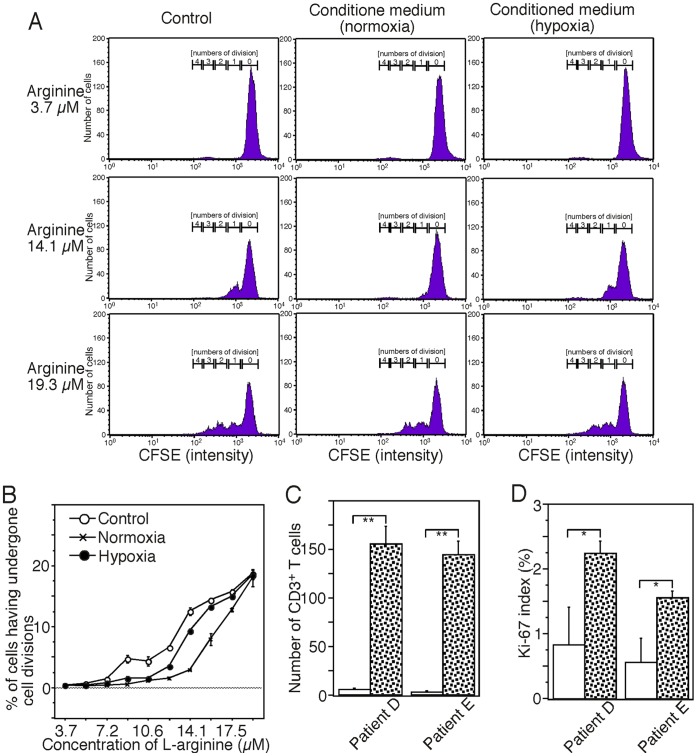
ARG2-expressing CAFs potentially affect the immune reaction.(A) T cell proliferation assay. CFSE-labeled CD3+ T cells were stimulated with anti-CD3/CD28 antibody-conjugated beads in fresh medium supplemented with the indicating L-arginine (control) or in conditioned medium after culture of CAFs under normoxic conditions (normoxia) or hypoxic conditions (hypoxia) in the medium with the indicating L-arginine (including 2.0 µM arginine of serum contents) for four days, and their proliferation profiles were analyzed by flow cytometry. Non-proliferated cells showed the highest fluorescence intensity and the intensity of the labeled T cells was halved with every cell division. The numbers represent the ratio of numbers of cells having undergone multiple divisions relative to the original number of cells. Data represent one of six independent experiments. (B) Percentages of cells having undergone cell divisions. Data represent one of six independent experiments. (C, D) Comparison of absolute number of tumor-infiltrating CD3+ T cells (C) with their proliferating index (the proportion of Ki-67-positive proliferating cells among the CD3+ T cells) (D) between the area around ARG2-expressing CAFs (white) and the area within the tumor except for necrotic tissue (speckled). We counted tumor-infiltrating CD3+ T cells and their Ki-67 positivity in each twenty different high-power fields per area categories using two PDC cases. Each data column represents the mean± SE for triplicate determinations. Significance value (Student’s t test) of P<0.05 (*) and P<0.001 (**).